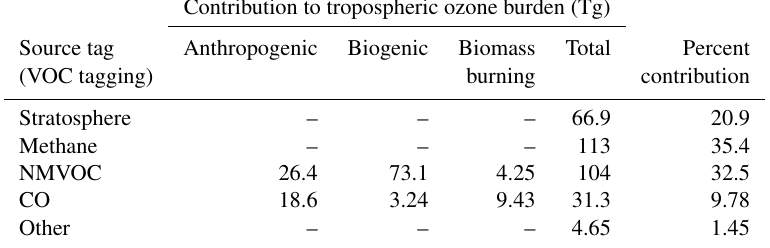
Table 2. Contribution to annual average tropospheric ozone burden from tagged sources of VOC and CO, and transport from the stratosphere. Sources of NMVOC and CO were further tagged as being of either anthropogenic, biogenic, or biomass burning origin. The contribution of these different individual source categories to the tropospheric ozone burden are also shown here in addition to the total contributions of each of these chemical species.